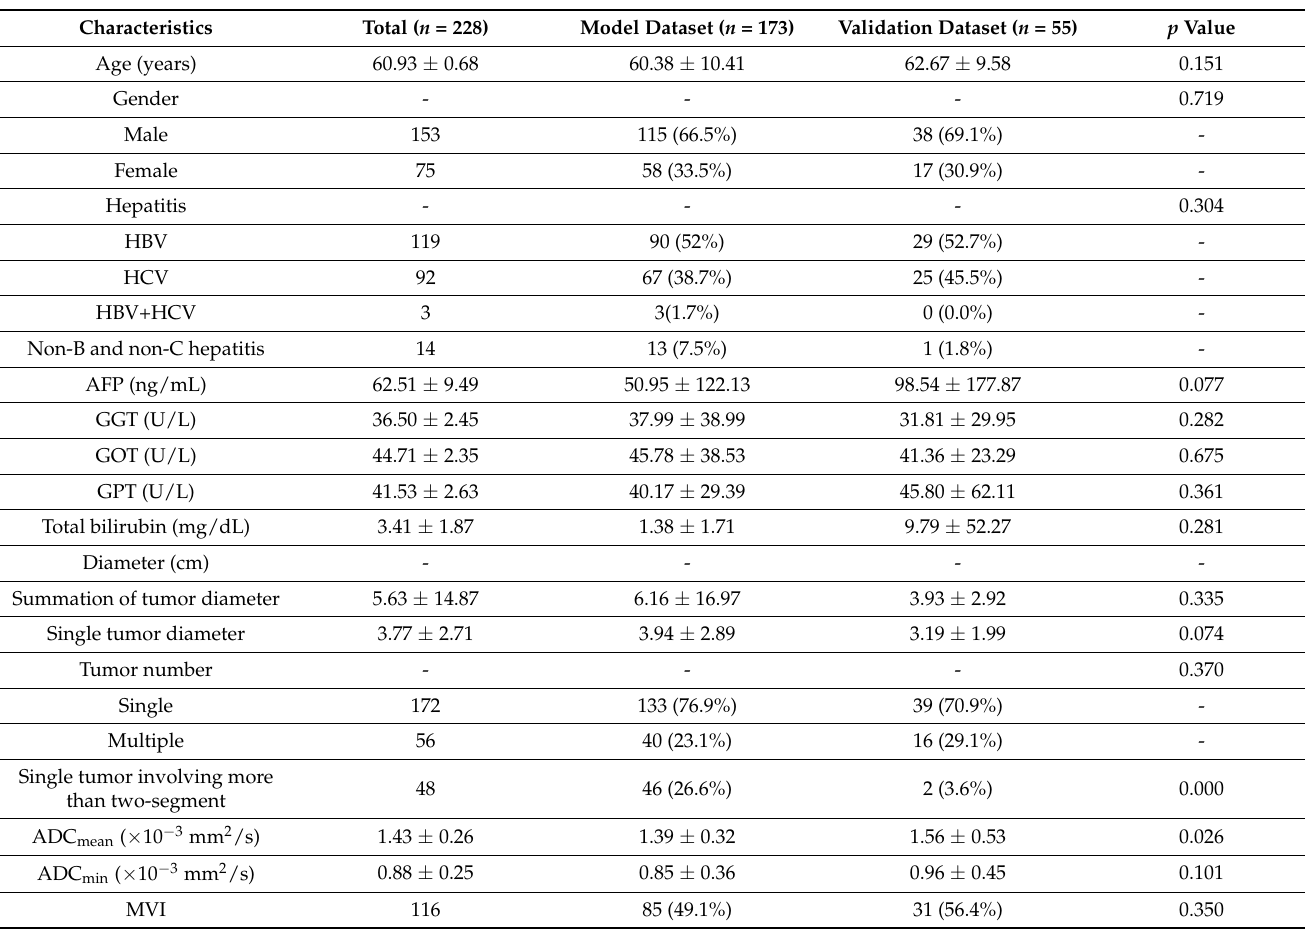
Table 1. Demographic and clinical characteristics of patients are divided into the model dataset (right liver lobe group) and validation dataset (left liver lobe